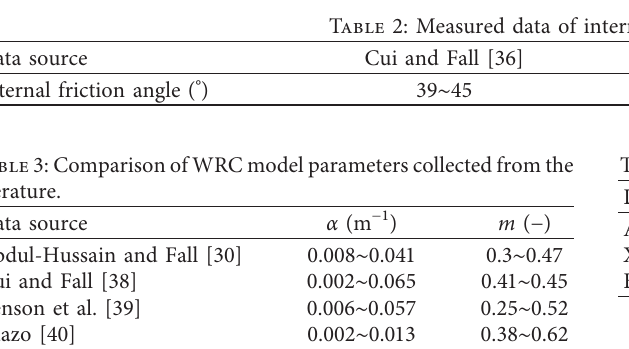
Table 6: Backfilling conditions adopted in the control stope